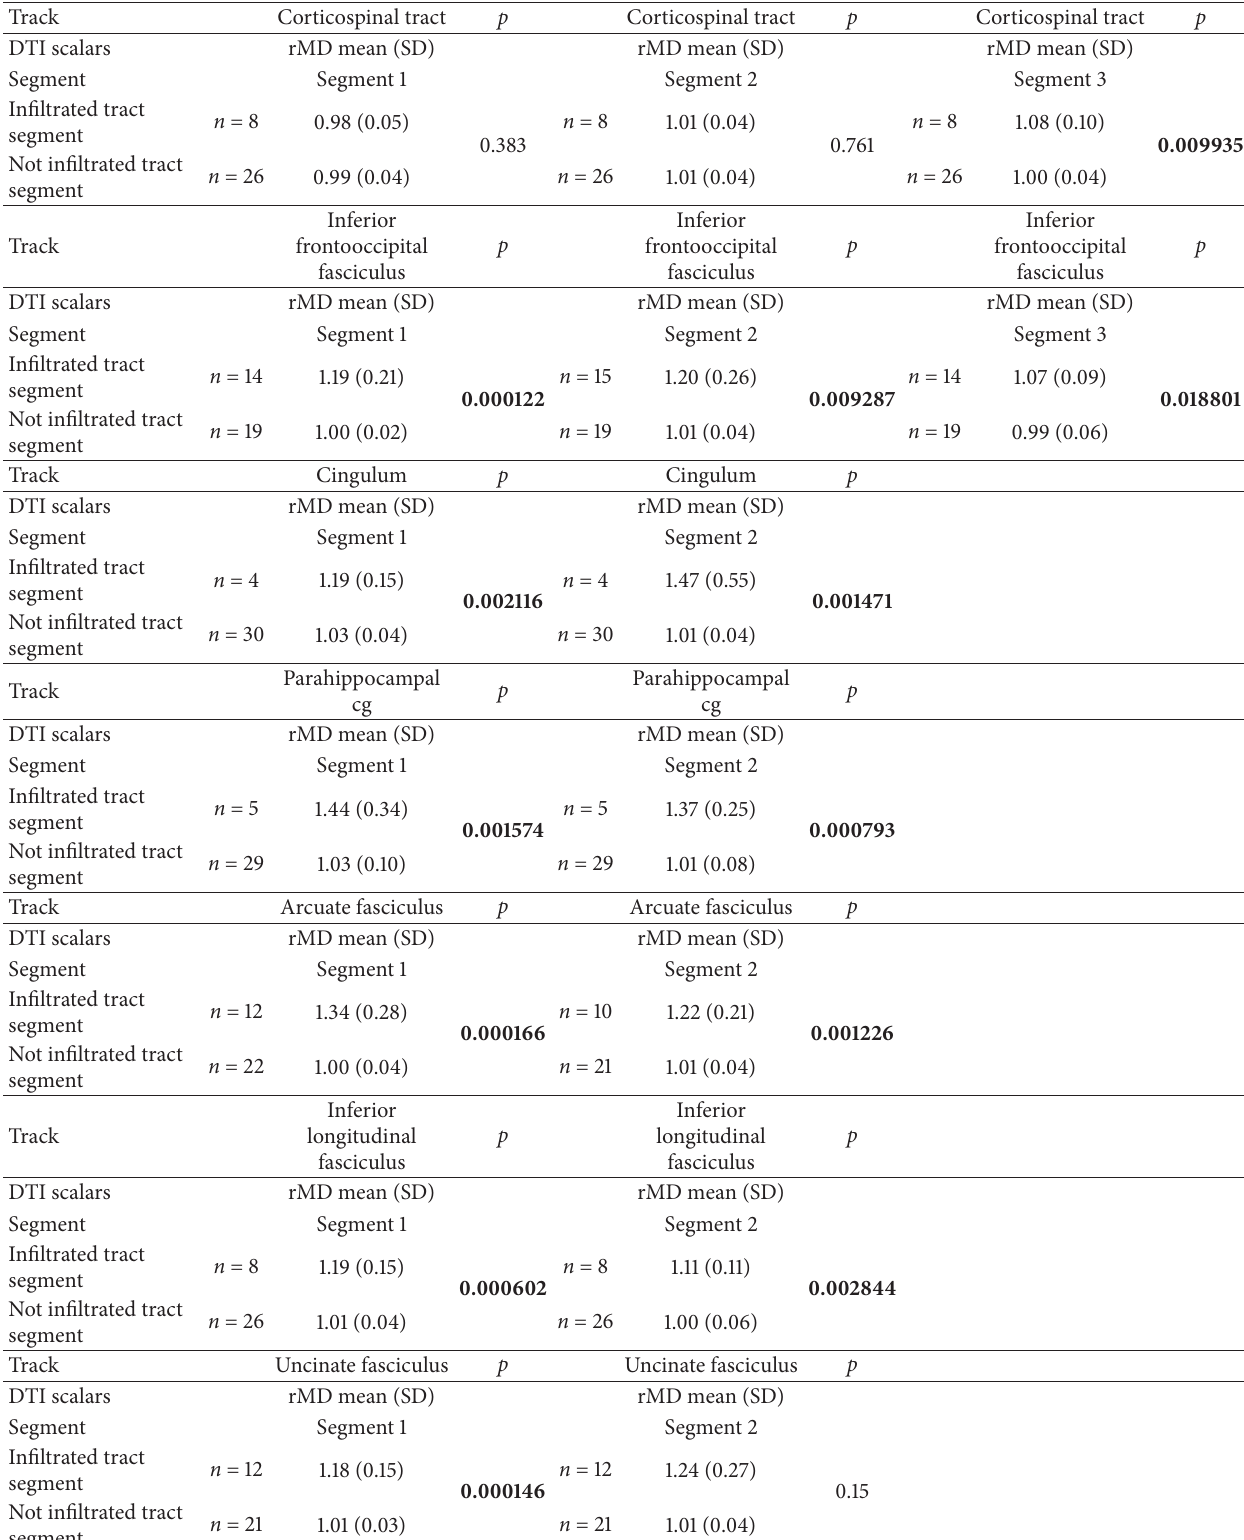
Table 3: Results from tractography, mean